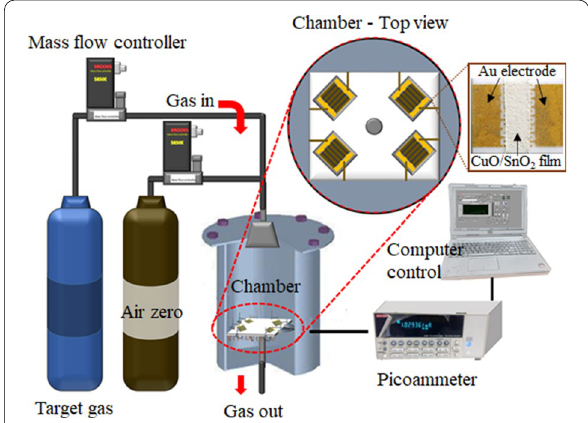
Fig. 1 Gas-sensing measurement system with the photograph of a CuO/SnO 2